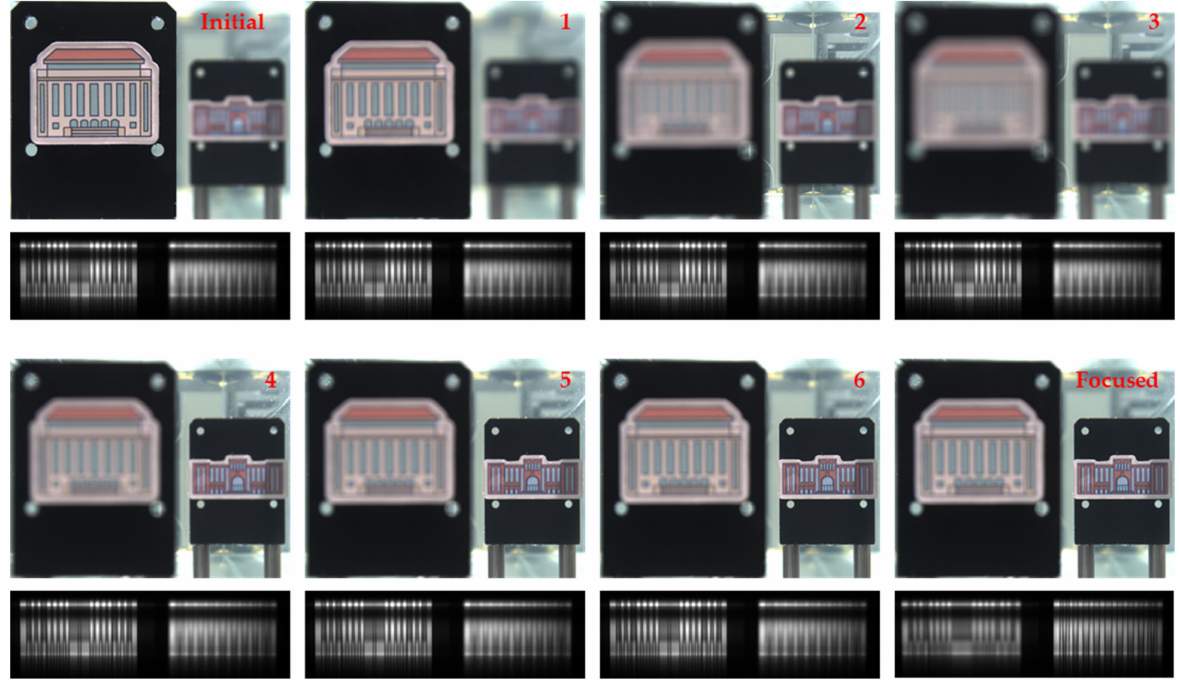
transfer from the RGB lens to the HSI lens.